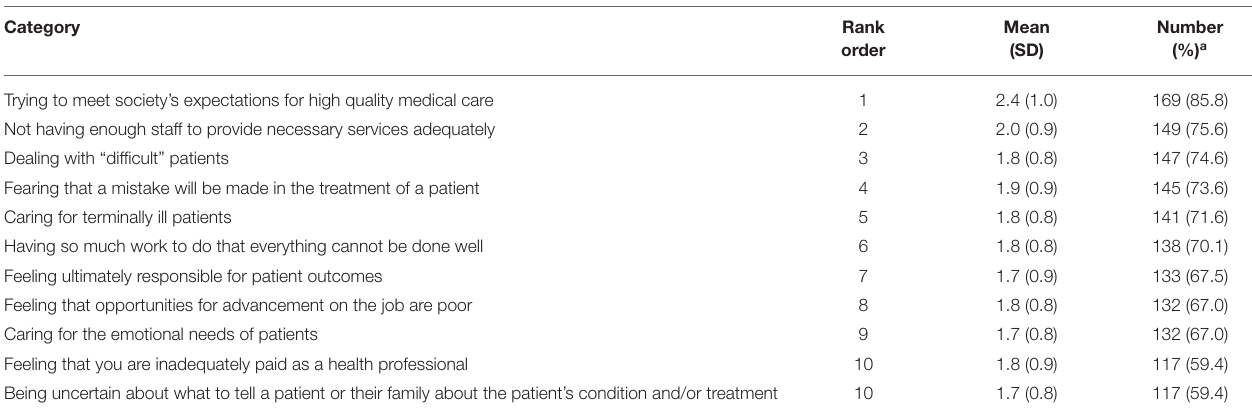
TABLE 3 | Rank orders of 10 most stressful